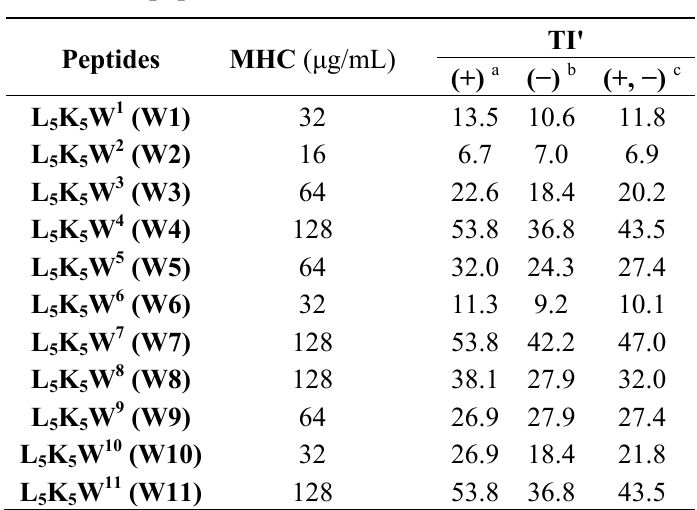
Table 2. Minimal hemolytic concentration (MHC) and pseudo-therapeutic index (TI') K W n model values of the L 5 5